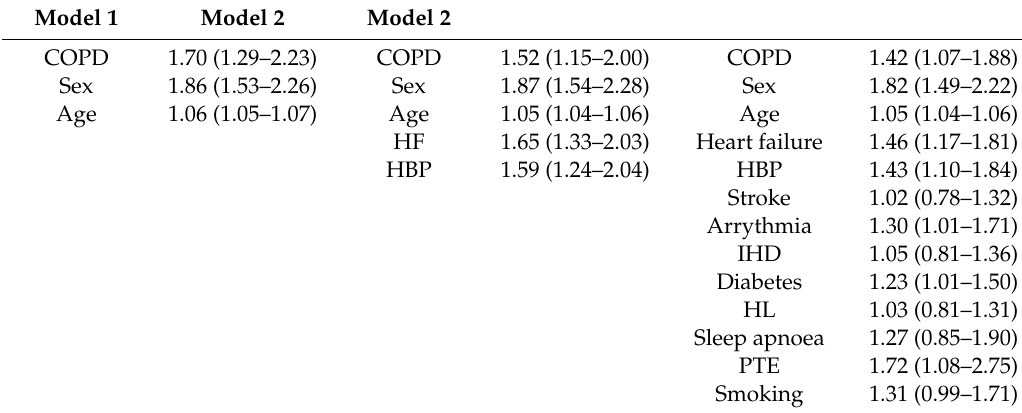
Table 5. Risk of death (OR and 95% CI) in COVID-19 patients with COPD versus those without COPD adjusted by covariates in several models of logistic regression multivariate